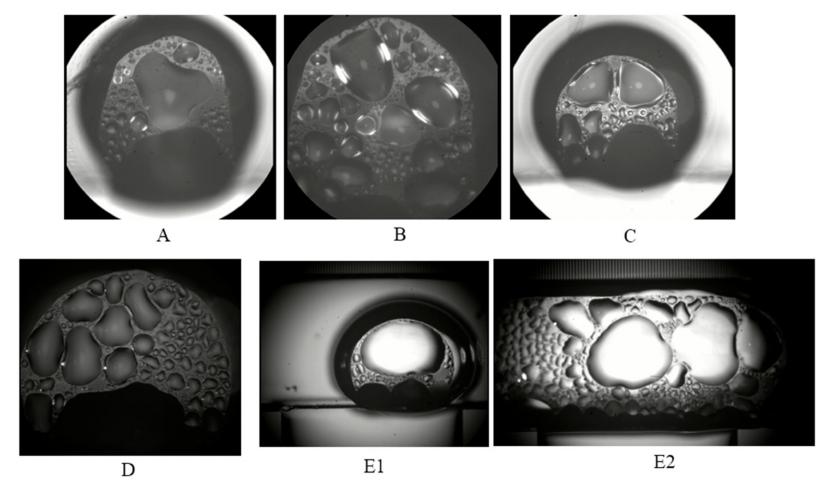
Figure 7. Startup process of the s-UTLHP.